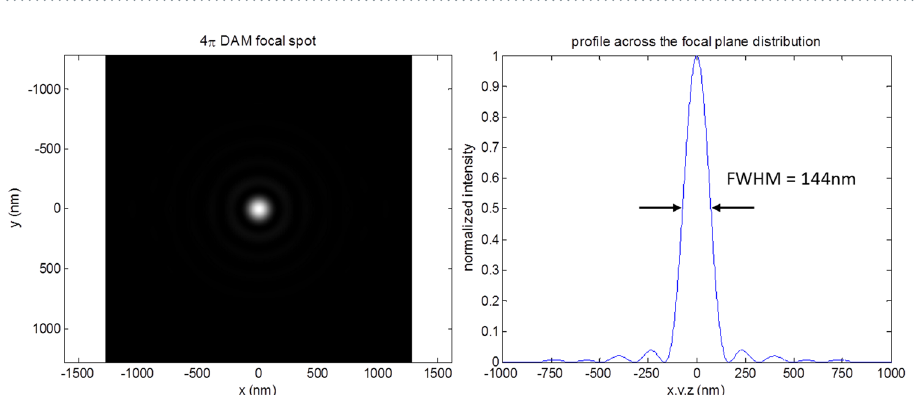
Figure 6. Focal spot for sources covering Ω = 4 π (4 π DAM). Intensity distribution when imaging with 9,016 sources distributed over π θ π Ω = × − ~ 2 2 (1 cos ) 4 (this cannot be realized with glass lenses, as it would theoretically correspond to two objective lenses each with NA = n sin(90°) = n, i.e. an acceptance cone with 180° opening angle). In this calculation, the refractive index at the position of the focus is given by n = 1.518. Left: Cross-section through the center of the light distribution in the focus. Right: Profile across the center of the light distribution in the focus. Note that for a sufficiently large number of equally distributed sources, the FWHM is equal in all three spatial directions (x, y,